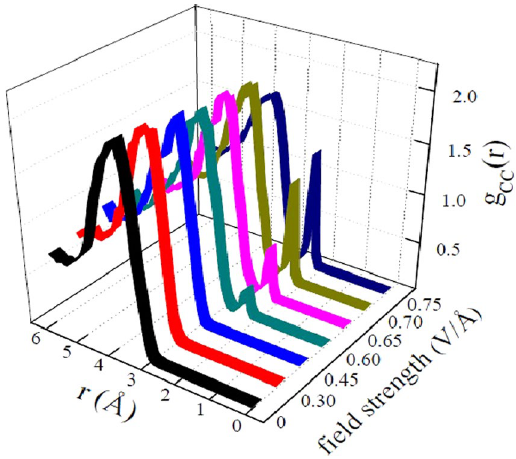
Figure 2. Carbon-carbon radial distribution function determined at different field strengths. Black curve: E = 0 V/Å; red curve: E = 0.30 V/Å; blue curve: E = 0.45 V/Å; cyan curve: E = 0.60 V/Å; pink curve: E = 0.65 V/Å; light green curve: E = 0.70 V/Å; dark blue curve: E = 0.75 V/Å. The synthesis of DME species starting from a field intensity of 0.60 V/Å is marked by the onset of a new peak located at ~2.4 Å. Above this strength, the stronger is the field the higher is the newly formed peak ( i . e ., a further increase of the field leads to a progressive accumulation of